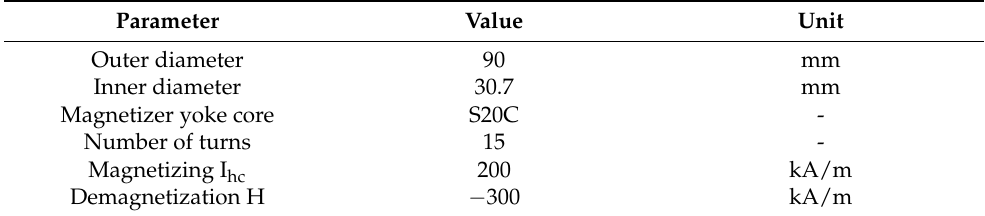
Figure 19. Magnetizer and magnetizing circuit; ( a ) configuration of magnetizer; ( b ) magnetizing circuit. Table 6. Magnetizer